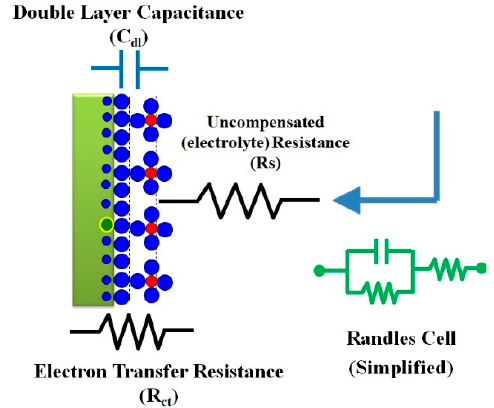
Figure 3. A simple demonstration to visualize what is going in the EIS systems during the conducting of experiments and before generating the EIS signals. At the electrode surface (definitely the side that faces the electrolyte containing the electroactive redox probe), oxidation and/or reduction will take place, which leads to an electron transfer or electron exchange. The diffusion, as well as the catalytic properties, will create different resistances including the charge transfer resistance (R ct ). To manipulate the EIS date, simulation or modeling through drawing on an electrical circuit (Randes cell) made of double-layer capacitors, solution resistance, and charge transfer resistance is